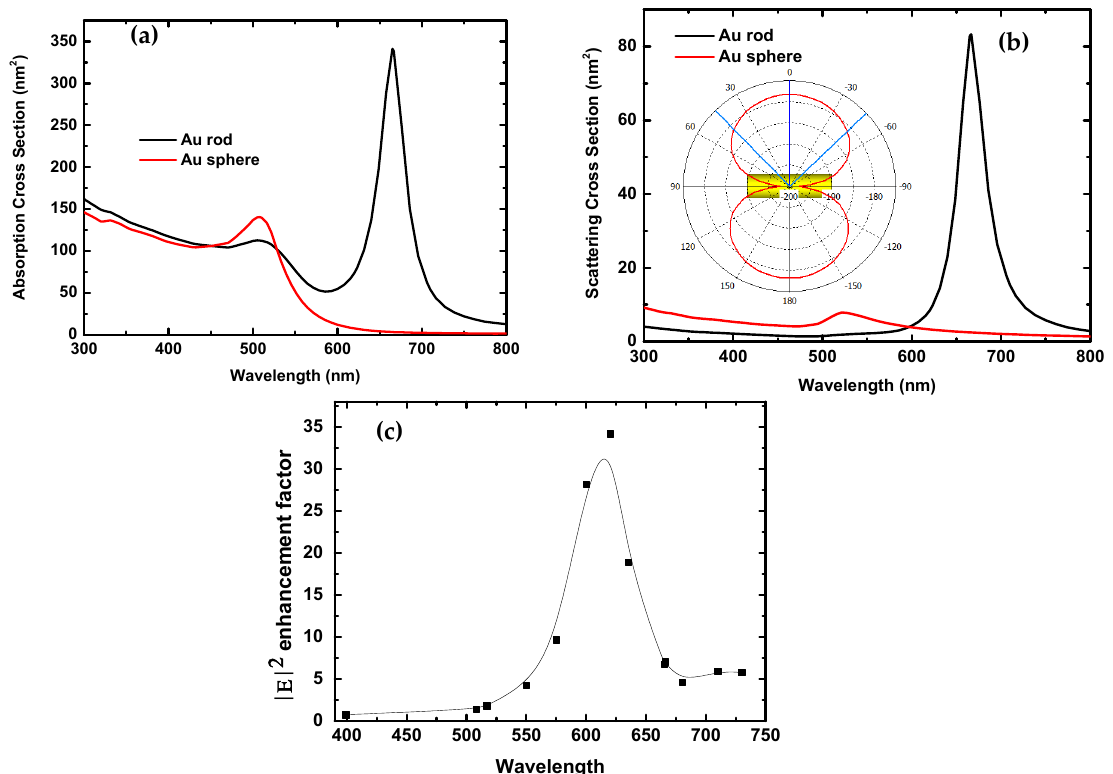
Figure 6. Calculated absorption ( a ) and scattering ( b ) cross-sections of an Au NR (40 nm in length and 11.6 nm in diameter) and sphere (20.06 nm in diameter) by a linear polarized plane wave in free space. The insert is the scattering diagram for the Au NR at a wavelength of 620 nm. ( c ) Maximal field intensity | E | 2 enhancement factor around the Au NR at di ff erent